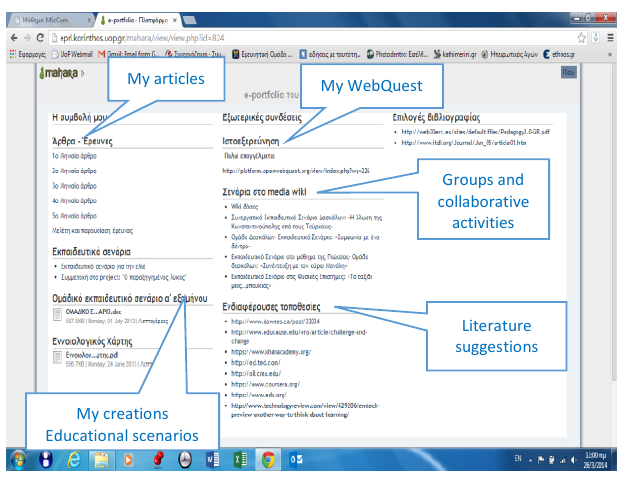
Figure 3. Main page of a typical student’s e-portfolio